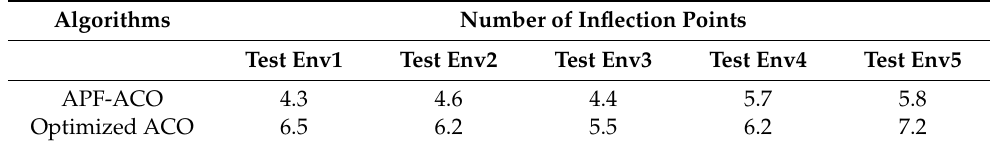
Table 6. Comparison of the number of inflection points between APF-ACO and Optimized ACO. Algorithms